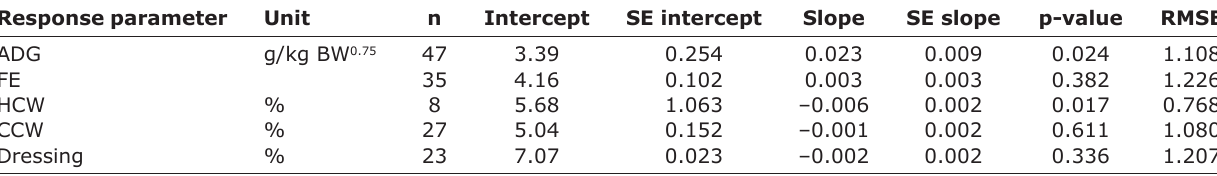
Table-4: Influence of urea supplementation (g/kg DMI) on sheep performance. Response